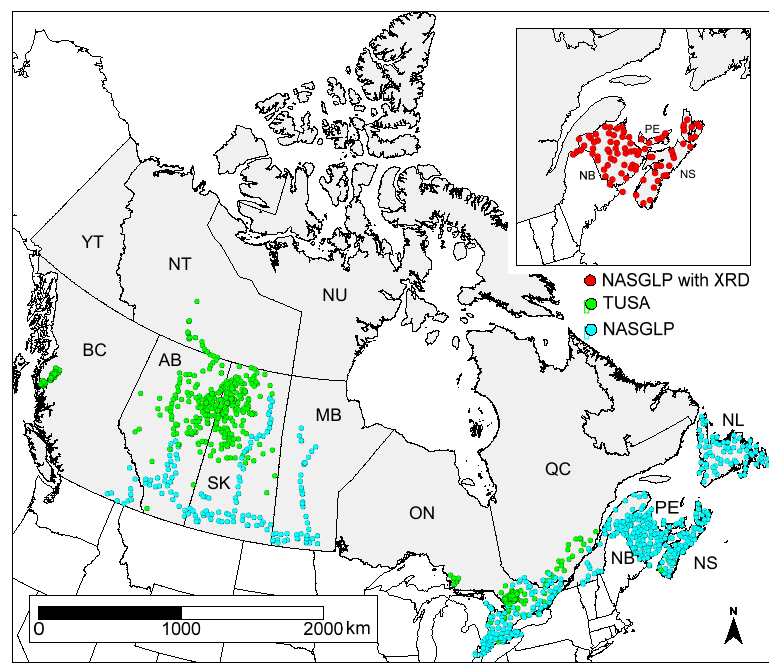
Figure 1. Location of study sites across Canada ( n = 1170) with soil major oxide content data from the North American Soil Geochemical Landscape Project (NASGLP) and Trent University Soil Archive (TUSA). Inset shows NASGLP sites ( n = 85) with paired major oxide data and X-ray Diffraction (XRD) mineralogy data (Map projection: Lambert Conformal Conic).